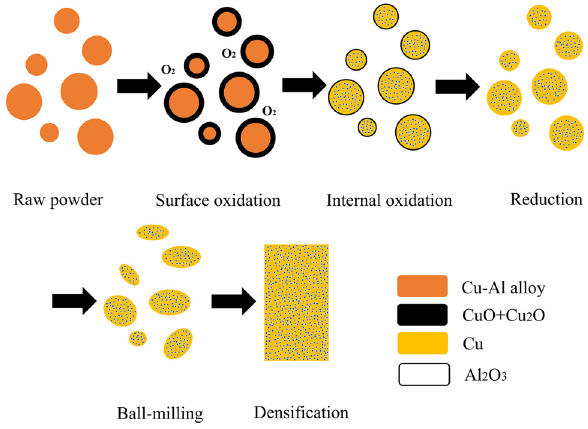
Figure 1: Schematic showing the